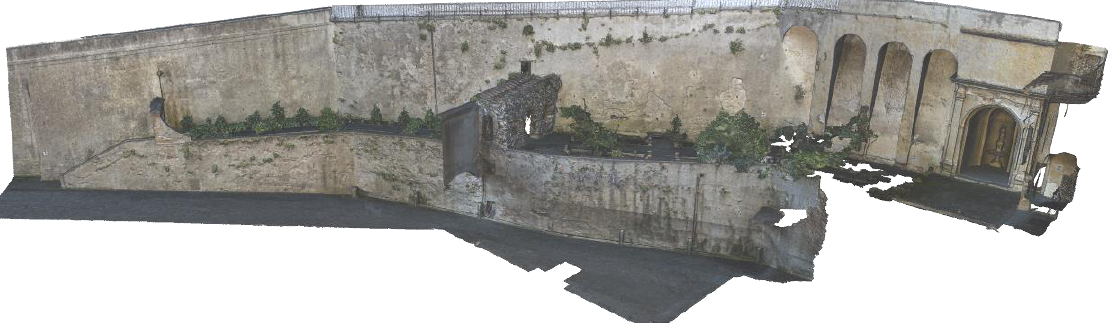
Figure 4. The mesh model